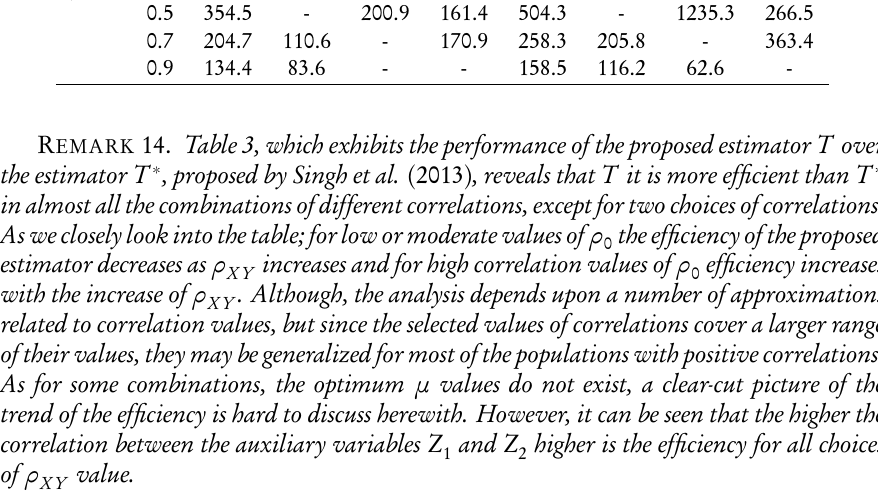
Values of E for some values of ρ